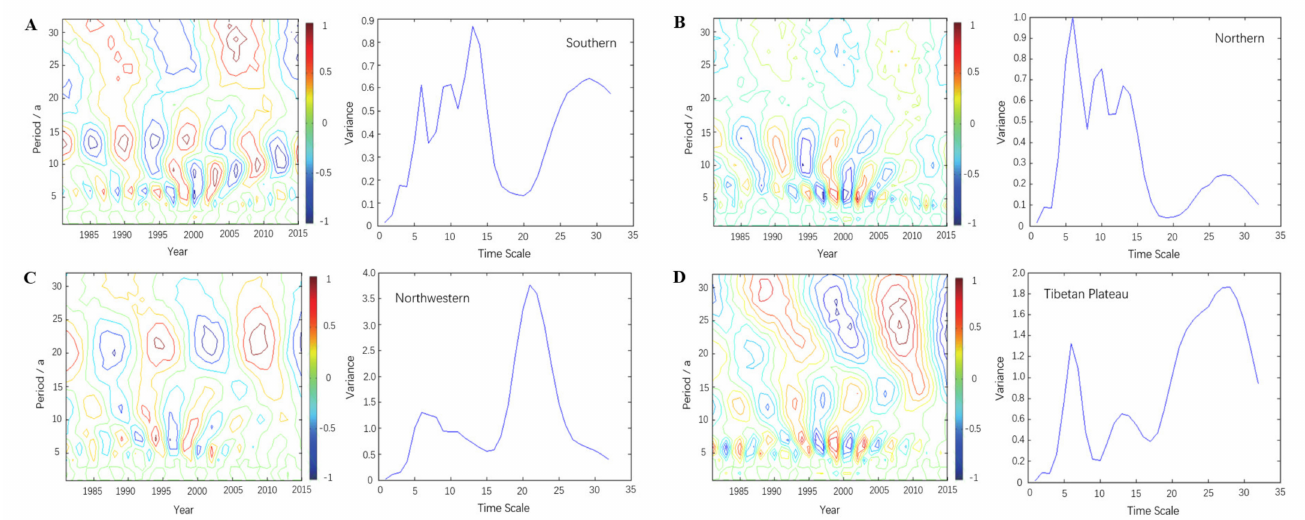
Figure 7. Spring VCI wavelet time series analysis maps for the southern ( A ), northern ( B ), northwestern ( C ) and Qinghai- Tibet ( D ) regions of